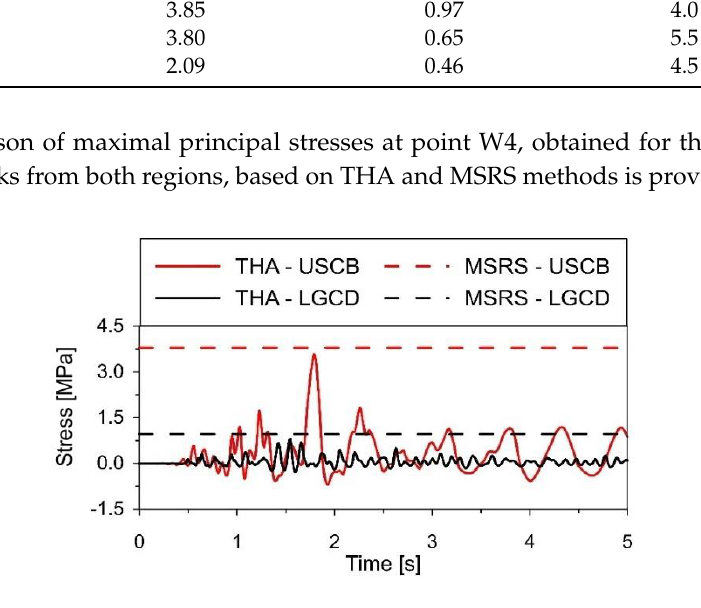
Table 4. Comparison of the stresses obtained for the shock from the di ff erent mining regions. Maximum Stress Obtained for Region (MPa): Element USCB